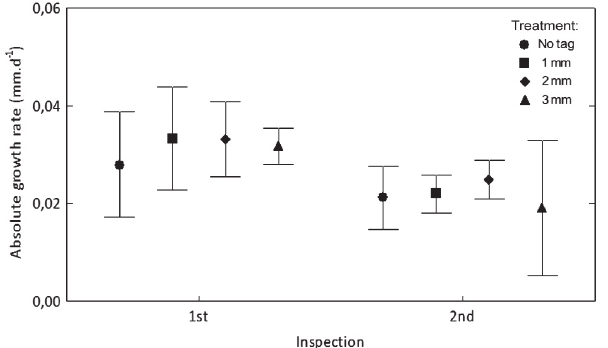
Fig. 1. Mean and 95% confidence interval of the absolute growth of juvenile curimbatá Prochilodus lineatus raised in concrete tanks at two inspection times for four treatments (no tag and coded wire tag injected at a depth of 1, 2, and 3